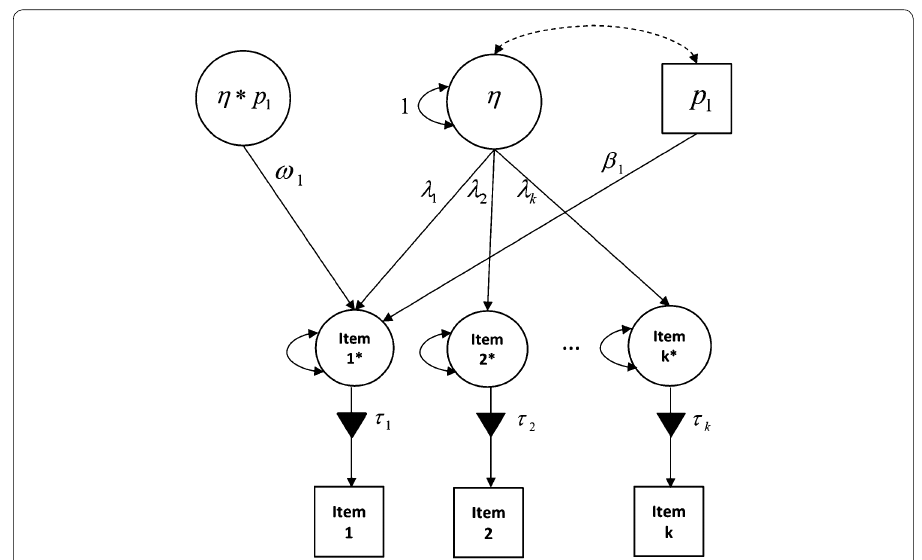
Fig. 1 The structural equation model for examining item position effects ( Note η tor loadings; τ 1 to τ k item thresholds; p 1 positions of item 1 on the test; β 1 = = item 1; ω 1 interaction term between latent trait and positions of item =